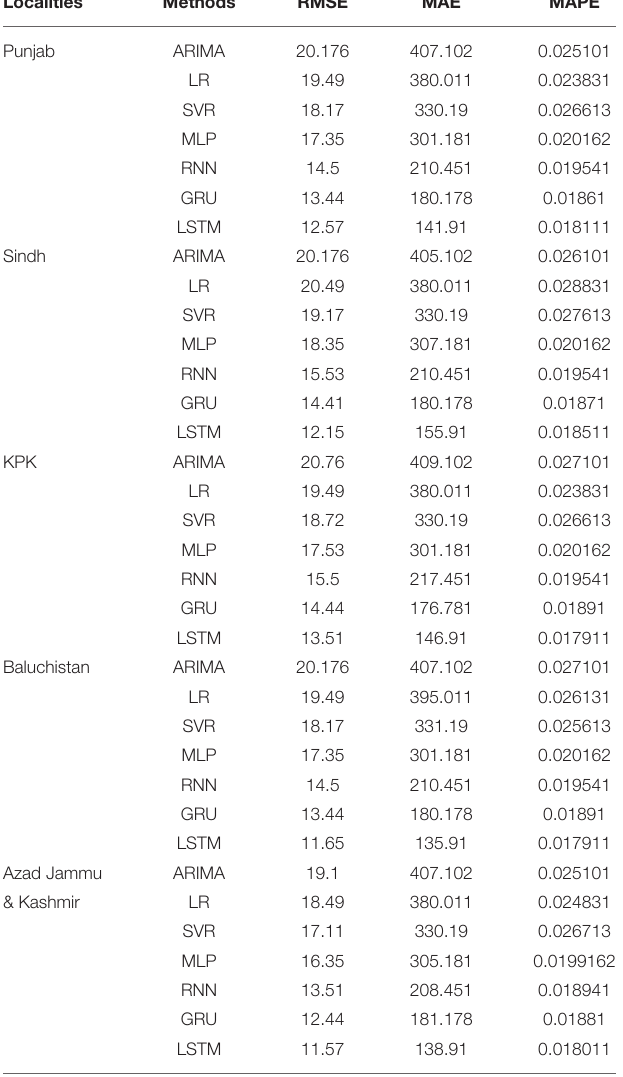
TABLE 1 | Validation matric for COVID-19 confirm case (actual vs. predicted) without temperature. Localities